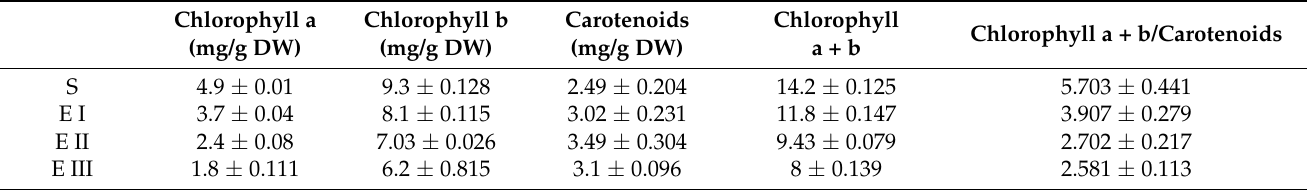
Table 3. Chlorophylls a, b, and carotenoids in different stages of the